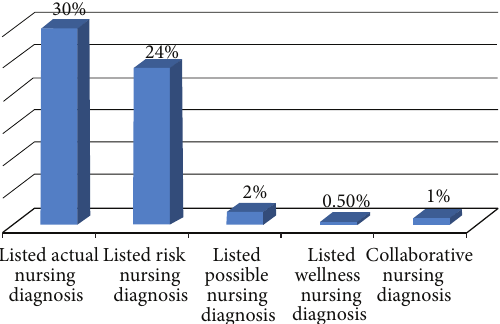
Figure 2: Distribution of nurses of Mekelle Zone Hospitals accord- ing to their awareness on the type of nursing diagnosis, northern Ethiopia, March 2011.